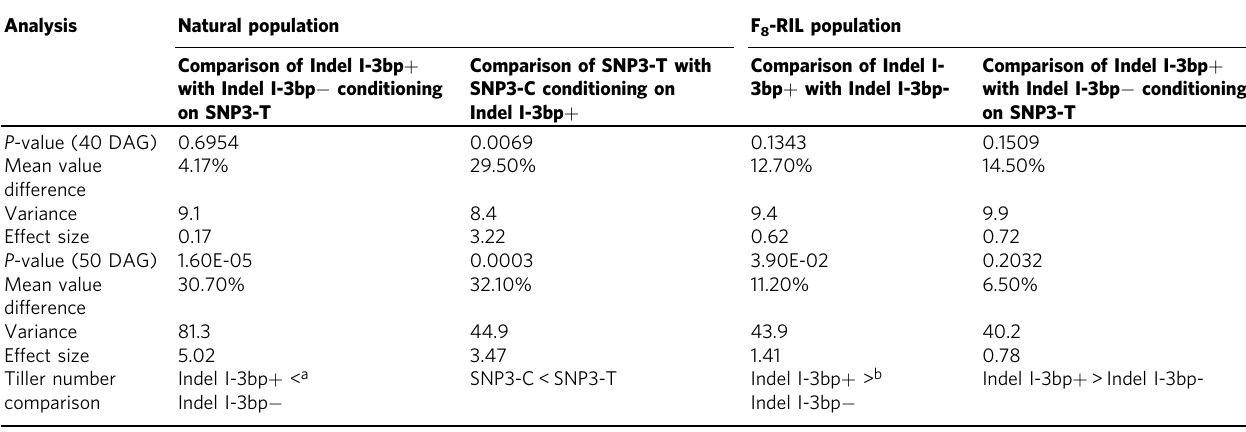
Table 2 Conditional analysis for Indel I and SNP3 in natural and F 8 -RIL populations.